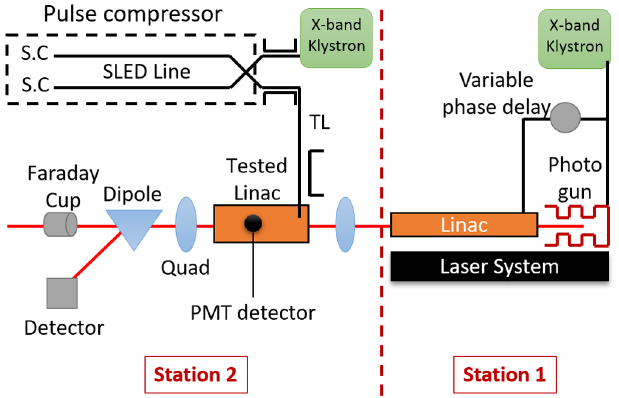
FIG. 9. The experimental setup for the distributed coupling linac testing at XTA, NLCTA, SLAC. XTA is divided into two stations, and can be referred to as station 1 and station 2. The first station generates the electron beam used in the experiment, and the distributed-couping linac is installed in the second station.